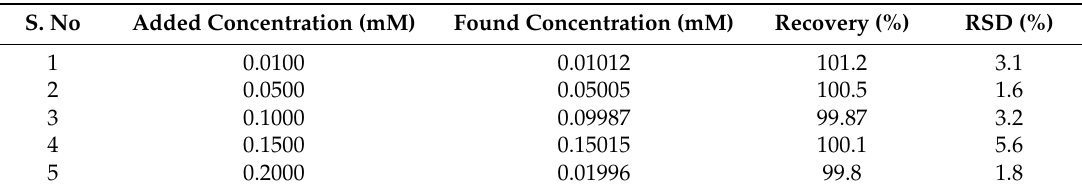
Table 2. The practical sample analysis result of hydrogen peroxide for the branch-truck Ag hierarchical nanostructures/GCE in pH 7 PBS (three repeated experiments).